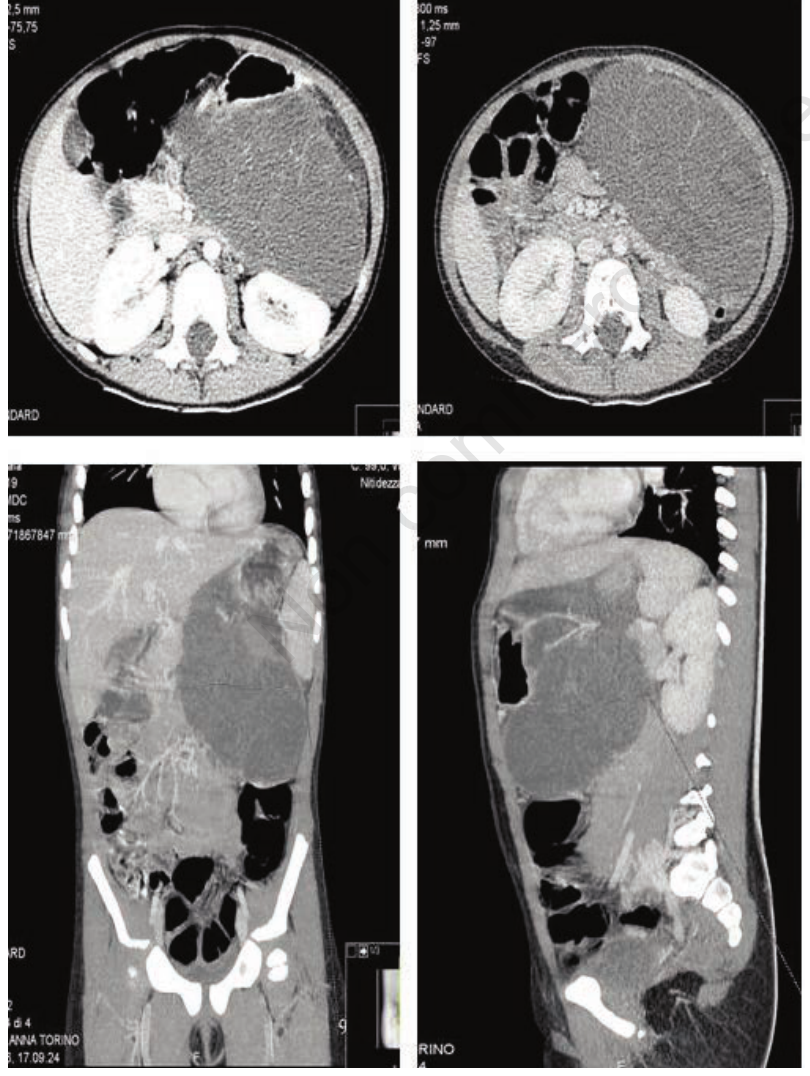
Figure 5. Abdominal Computed tomography scan of a large cystic mass (mesenteric lym-